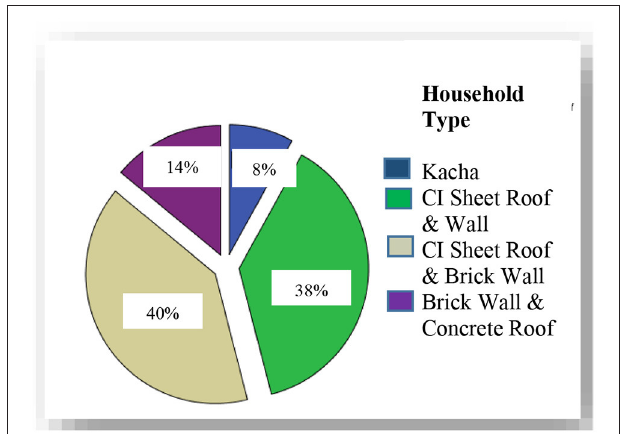
FIGURE 3 | Respondents’ economic status.